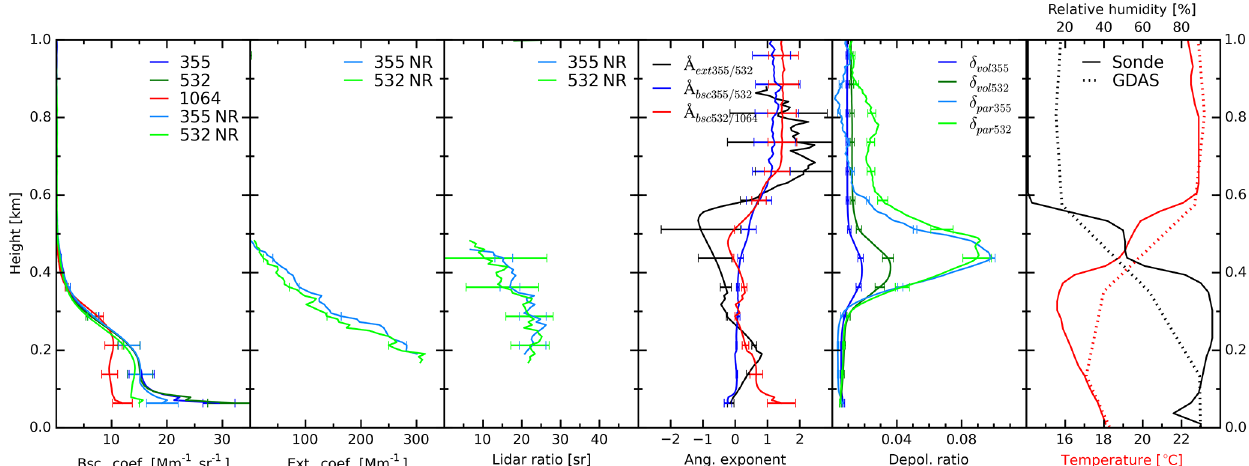
Figure 5. Profiles averaged for 30 November 2015, 01:15–02:30UTC. Backscatter coefficient and depolarisation ratios are smoothed with 127.5m vertical length. Extinction coefficients, lidar ratios, and Ångström exponents are smoothed with 127.5 up to 242m and afterwards with 367.5m. Meteorological data from GDAS1 (30 November 2015, 00:00UTC) and radio sounding measurements (29 November 2015, 12:00UTC) are also presented.